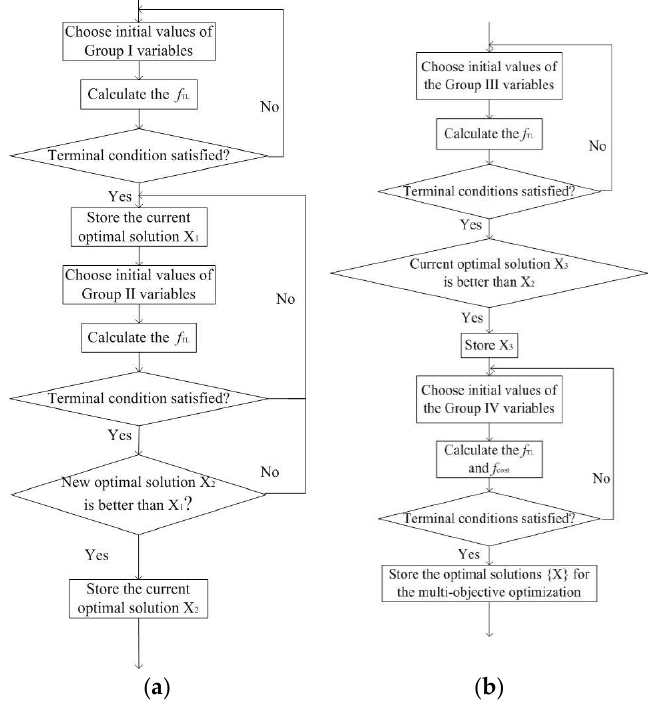
Figure 8. Optimization processes of stator and rotor. ( a ) Stator; ( b ) Rotor.